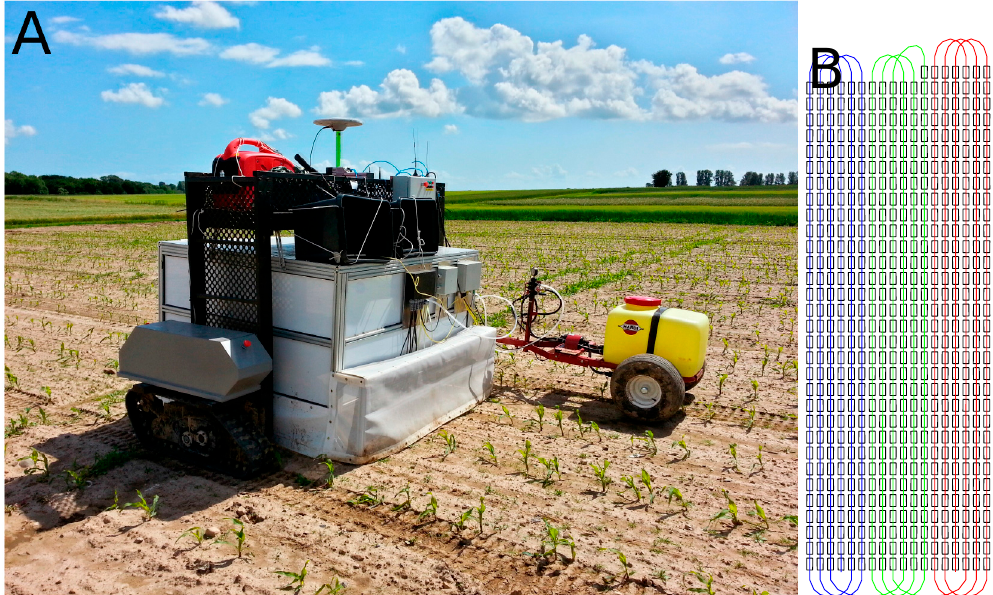
Figure 6. ( A ) Armadillo tool carrier equipped with a vision system and six spray nozzles dragging a Hardi ATV trailer with spray liquid; ( B ) Layout showing all the plots of the trial rotated by 70 ◦ . The colored lines show the overall route plan passing all plots, and the color changes indicate a pit stop every 900 m to refuel the Hardi ATV trailer carrying the